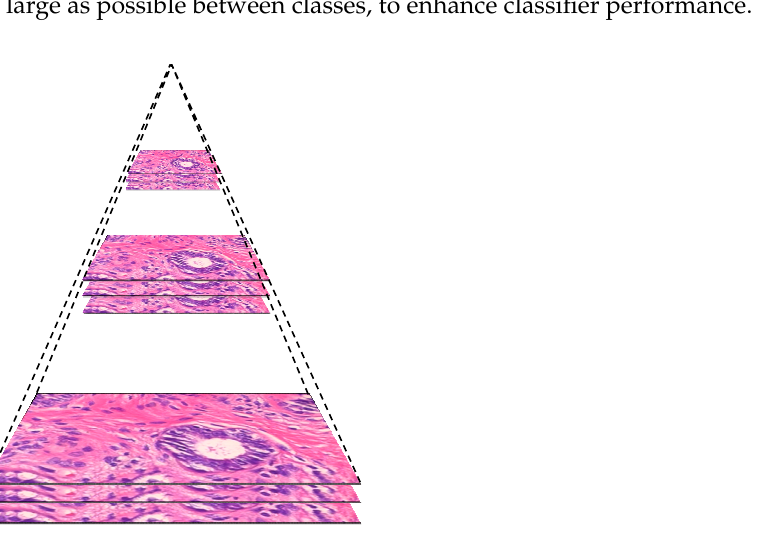
Figure 5. The image pyramid of inputting image.